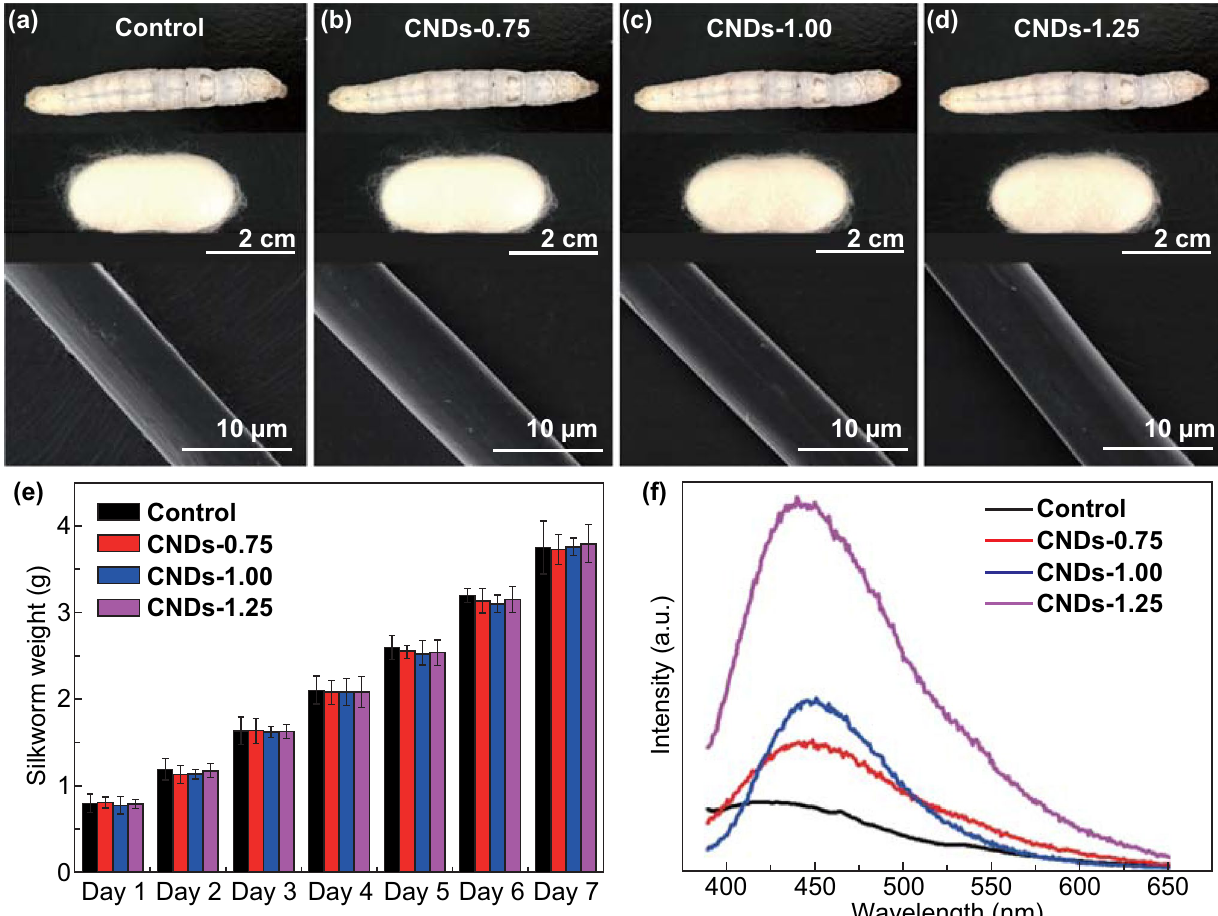
Fig. 1 Preparation of multi‑functional silk from silkworms fed CNDs. a – d Photographs of mature larvae fed different diets, corresponding cocoons and degummed silks. e Weight of silkworm larvae of the fifth instar from first to seventh day. f PL spectra of degummed silks measured using an excitation wavelength of 370